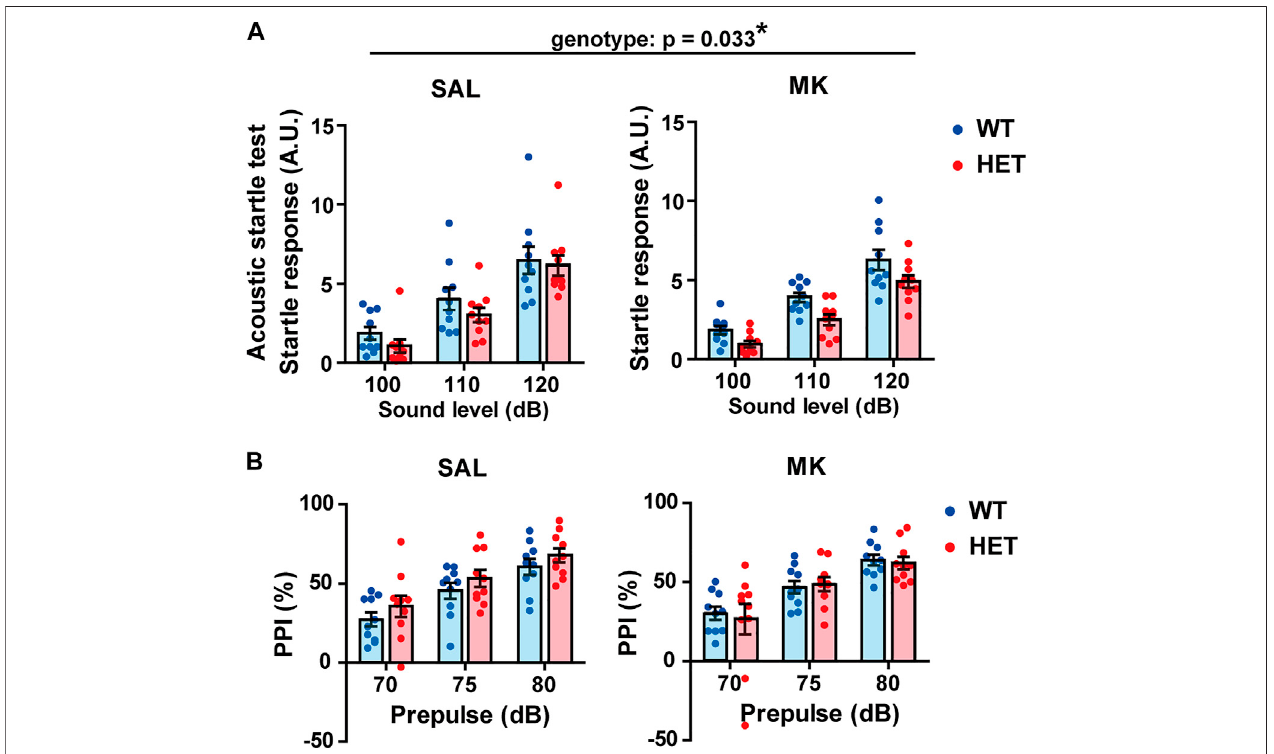
FIGURE3| Acousticstartleresponsewasdecreasedin Gad1 HETrats. (A) StartleamplitudesofHETratswerelowerthanthoseofWTratsirrespectiveofMK-801 treatment ( p (cid:2) 0.033). (B) Prepulse inhibition (PPI) was not affected by Gad1 genotype and MK-801 treatment. The results are presented as average ± SEM. Data were analyzed using three-way repeated-measures ANOVA. If a signi fi cant interaction of gene × drug was observed, a post hoc simple main effect test was performed. WT: wild-type, HET: Gad1 +/ − , SAL: saline, MK: MK-801. * p < 0.05.